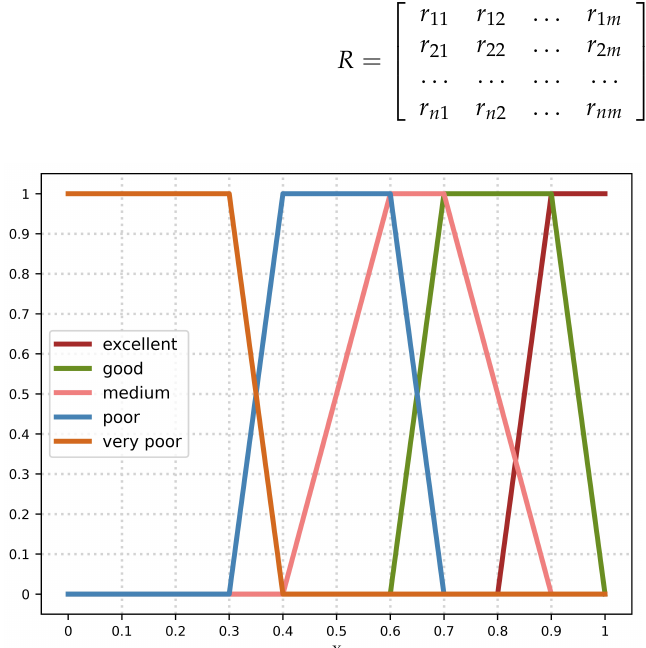
Figure 8. Fuzzy membership function. X reflects the relationship of a certain characteristic between simulated and real images.